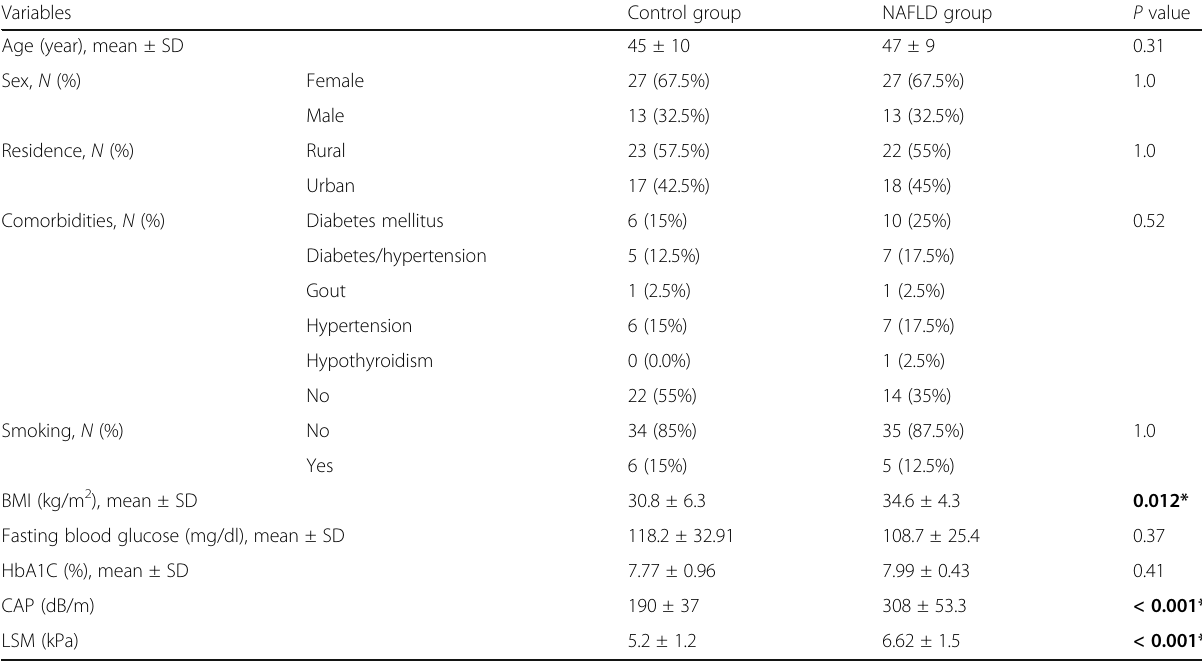
Table 1 Baseline characteristics of the two study groups at baseline